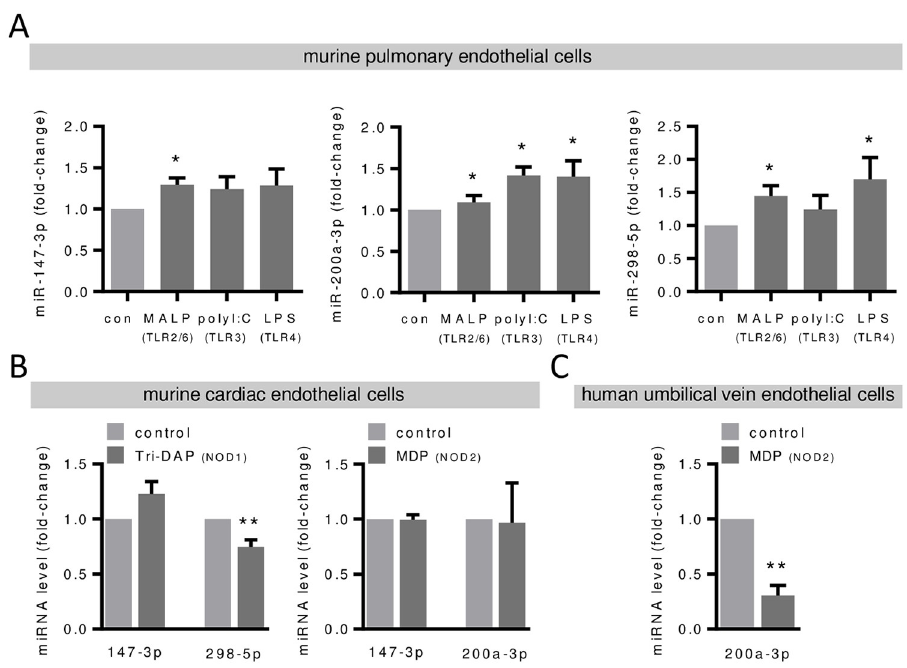
Fig 5. TLR- and NOD-dependent levels of miR-147-3p, miR-200a-3p and miR-298-5p in different endothelial cells. MiRNA levels of miR-147-3p, miR-200a-3p and miR-298-5p were analyzed 6 hours after MALP-2 (1 μ g/mL), polyI:C (1 μ g/mL) or LPS (0.1 μ g/mL) stimulation in ( A ) murine pulmonary endothelial cells and after Tri-DAP or MDP stimulation (each 10 μ g/mL) in ( B ) murine coronary endothelial cells and in ( C ) human umbilical vein endothelial cells by real-time PCR. � P < 0.05, �� P < 0.01 vs. unstimulated control, n =